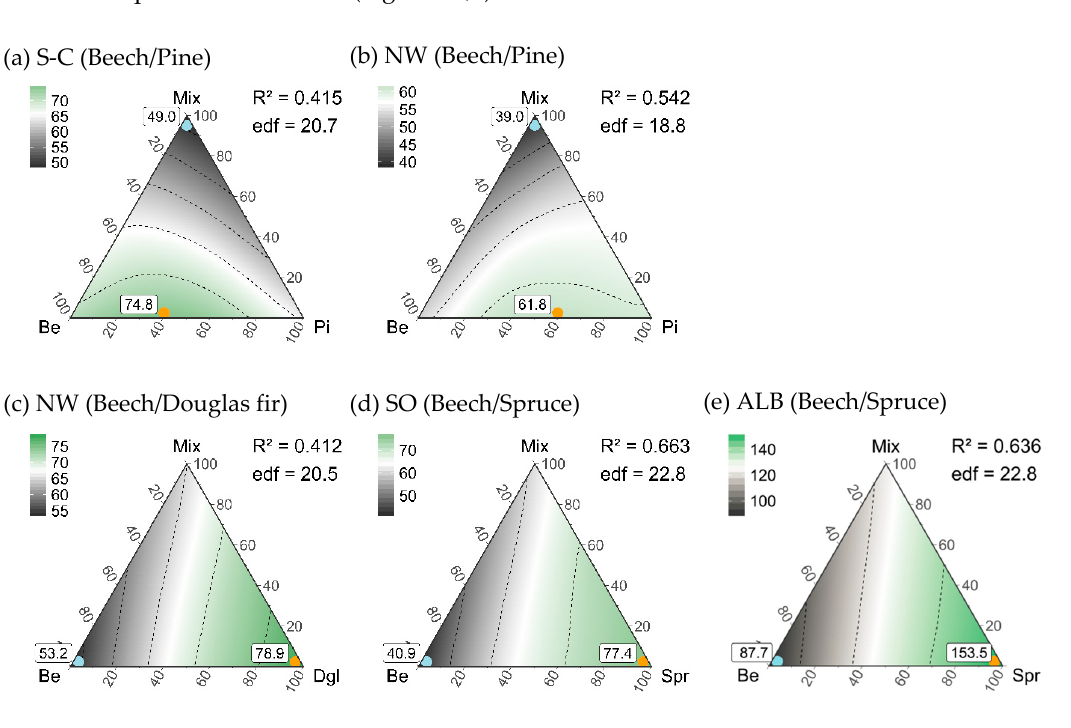
pure pine stands supported on average 19.5 and 19.3 exclusive species. Mean exclusive species numbers of pure beech stands (26.5 species in Schorfheide-Chorin, 12.1 species in NW-Germany) also exceeded numbers of beech/pine mixtures.